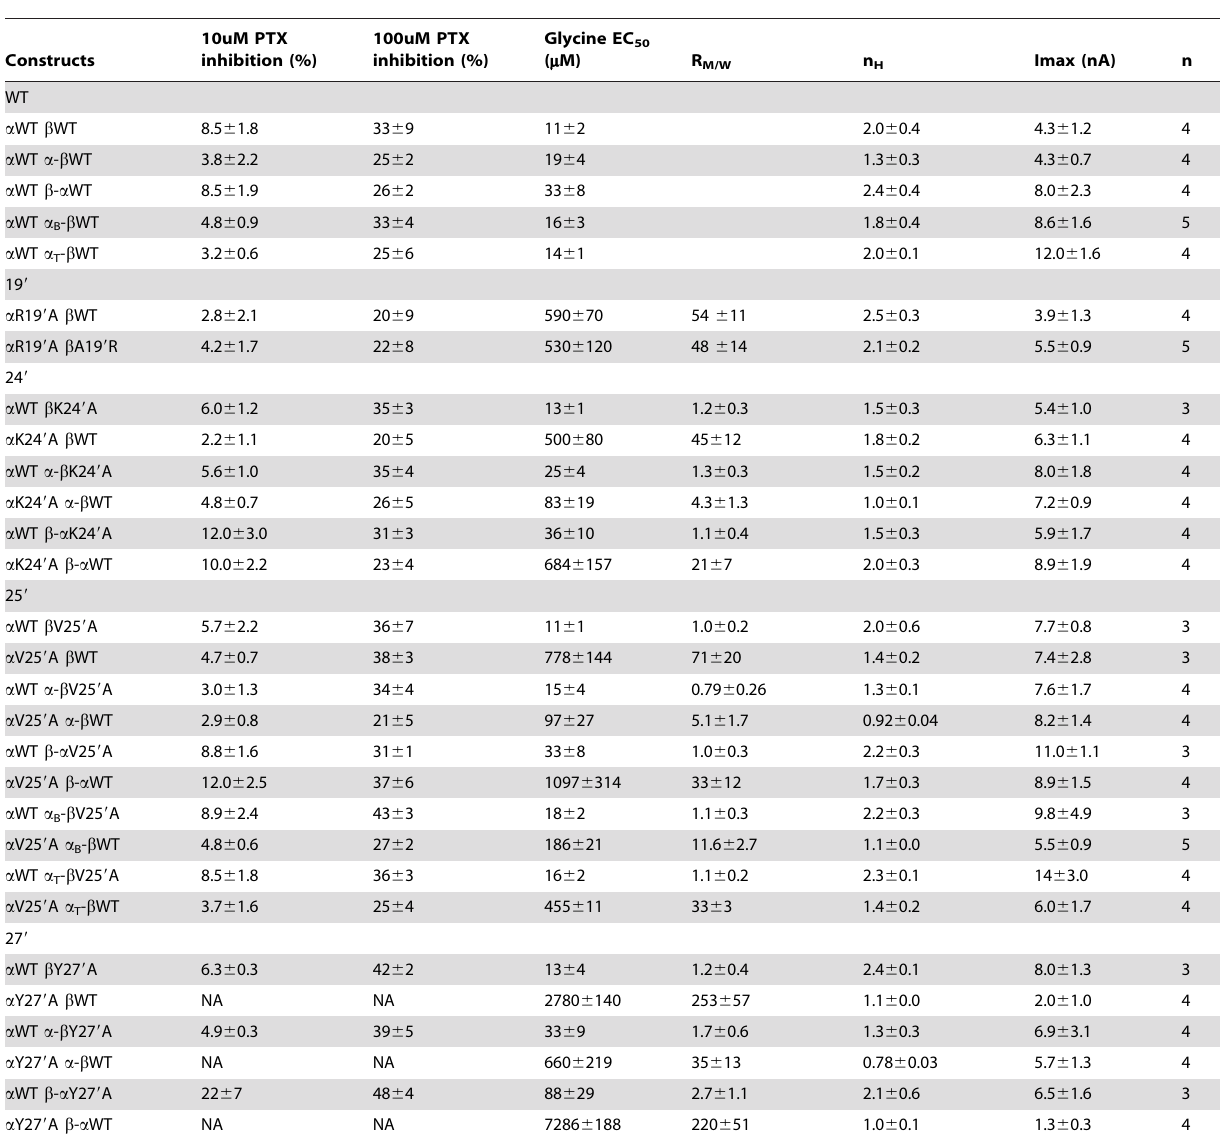
Table 1. Properties of glycine induced currents of GlyRs recorded in the HEK293 cells.